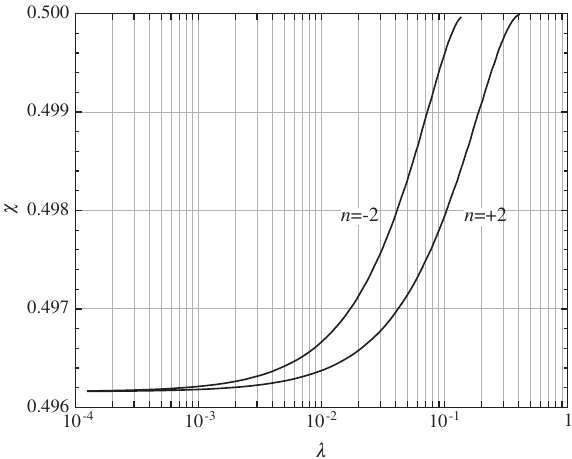
Figure 5: Dispersion curves corresponding to an inhomogeneous MEE layer with profile P0 ( n = ± 2) on homogeneous substrate for unity dimensionless depth of the layer β h = 1.